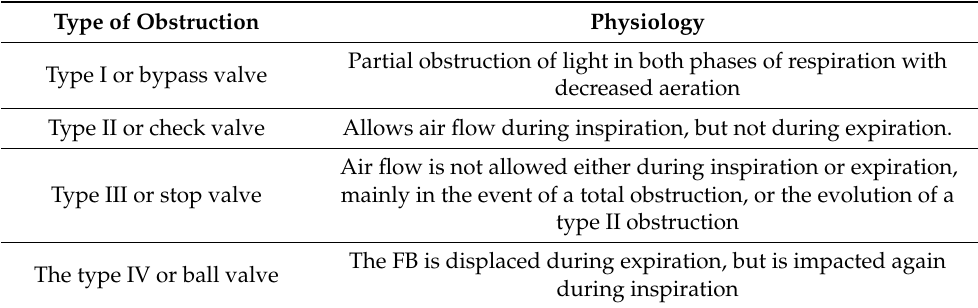
Table 1. Types of bronchial obstruction that occur in the presence of a foreign body in the airway. Type of